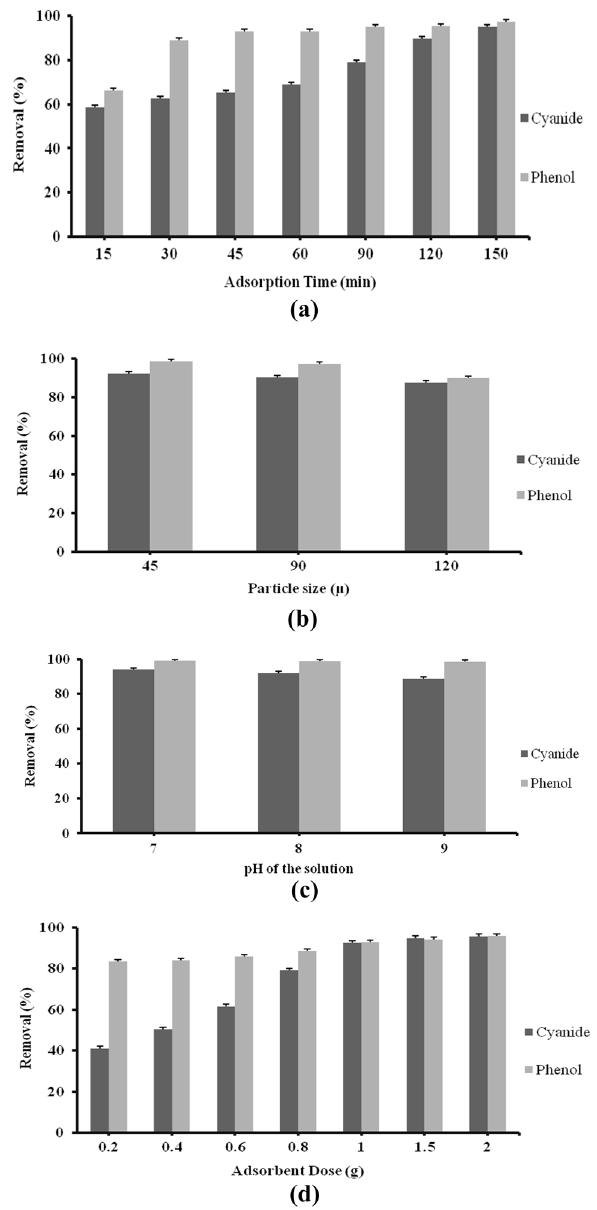
Fig. 7 a Variation of removal of pollutants with contact time. b Variation of removal of pollutants with particle size. c Variation of removal of pollutants with initial pH of the solution. d Variation of removal of pollutants with adsorbent